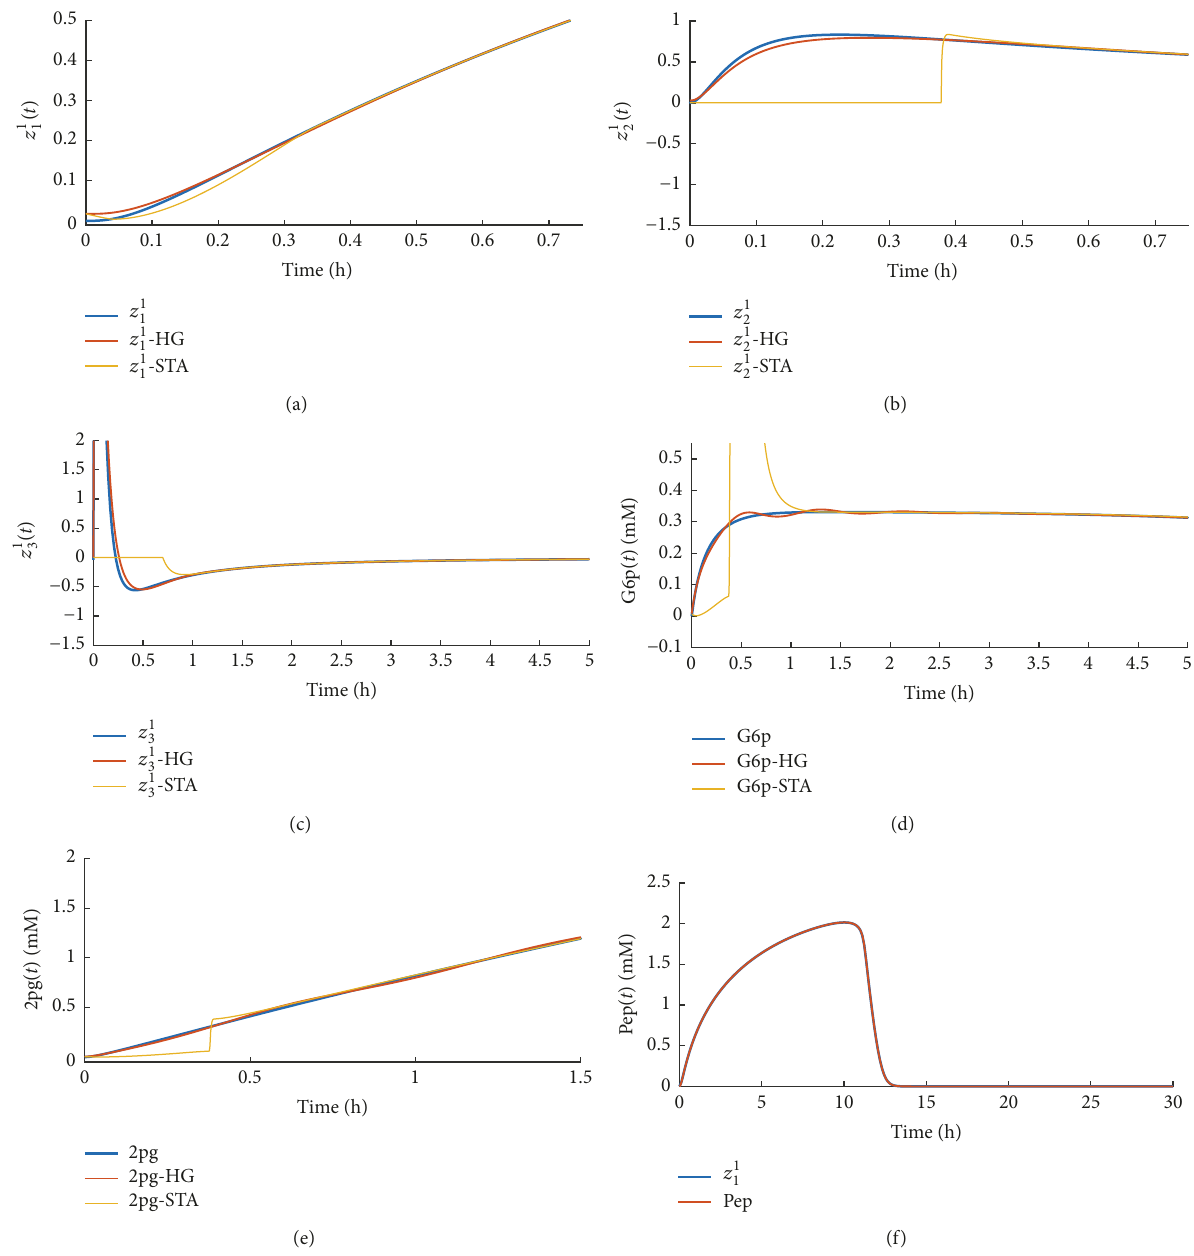
Figure 3: Detailed simultaneous visualization for the states of the transformed coordinates in the first subsystem, the corresponding high- gain observer, and the STA-based estimator: (a) 𝑧 1 1 , (b) 𝑧 1 2 , and (c) 𝑧 1 3 during the first 5 hours. (d)–(f) depict the detailed variation of the concentrations for the compounds (d) G 6 p, (e) 2 pg, and (f) Pep as well as their estimates produced by the inverse transformation applied to both the high-gain and the STA-based observer during the first 5